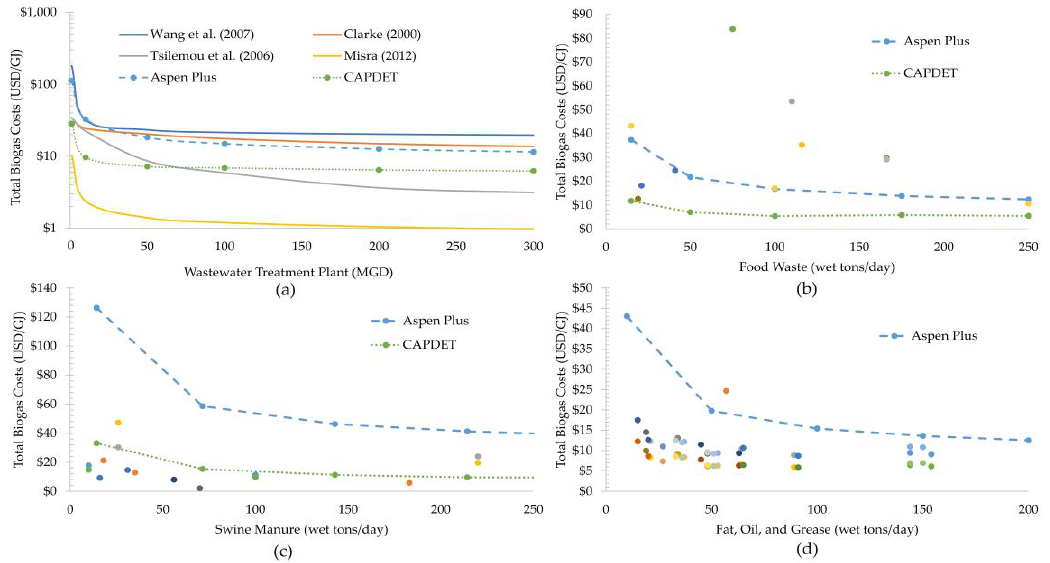
Figure 7. Total Biogas Production Costs in USD/GJ for AD Processing ( a ) Wastewater Treatment Sludge, ( b ) Food Waste, ( c ) Swine Manure, and ( d ) Fat, Oil, and Grease. Please note that that y -axis on Figure 7( a ) is plotted on a log-scale.